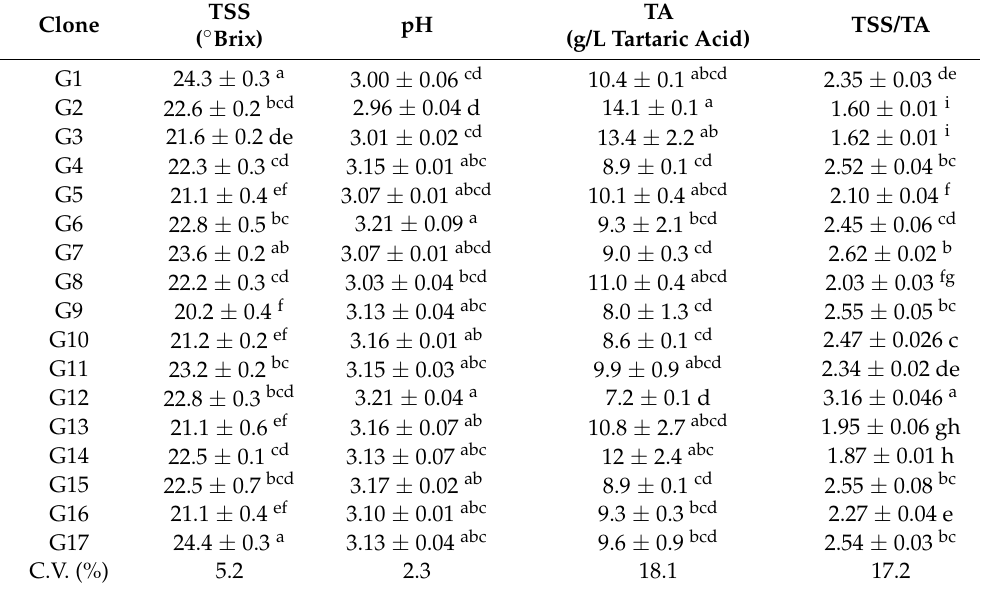
Table 2. Berry composition of the different clones at harvest. The harvest date for clones G7, G9, G12, G15, and G17 (8 October 2019) was six days later than the other clones (2 October 2019). In each column, different statistical letters indicate statistically significant groups according to a one-way ANOVA followed by Duncan post-hoc test ( p ≤ 0.05). The Coefficient of Variation (C.V.) among clones was reported for each measured